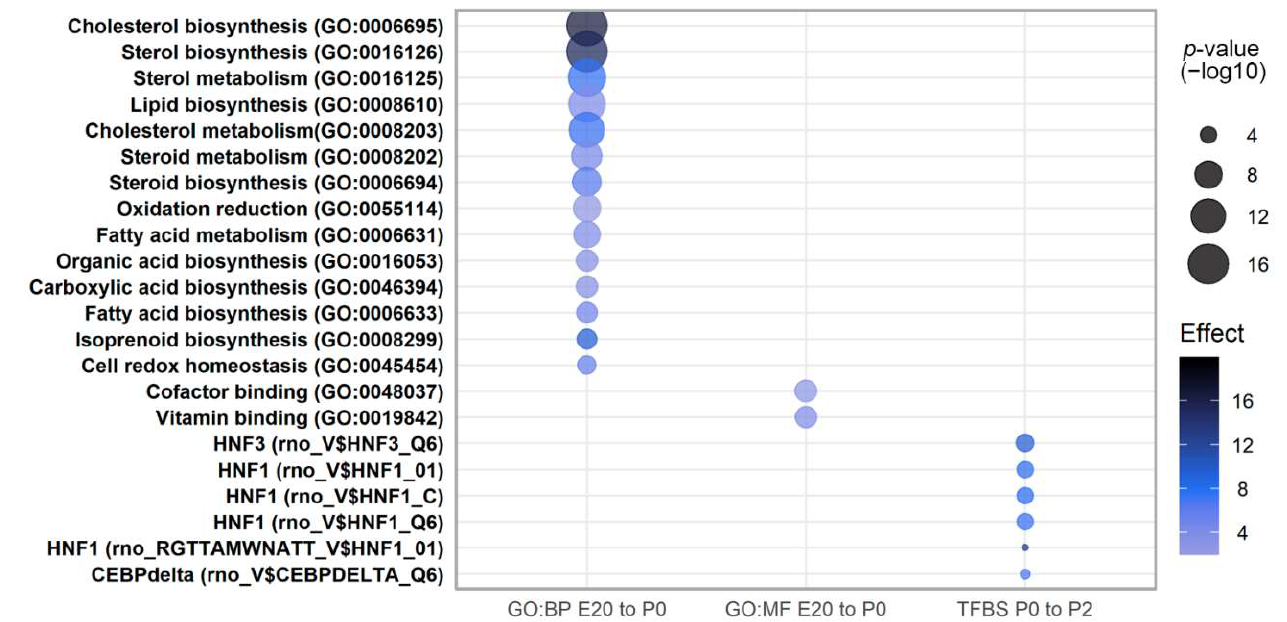
Figure 5. Gene Ontology biological processes and molecular functions,) which are significantly over-represented in the gene lists of differentially expressed genes at E20 vs. P0, and significantly enriched transcription factor binding sites (TFBS) based on differentially regulated genes between P0 and P2.